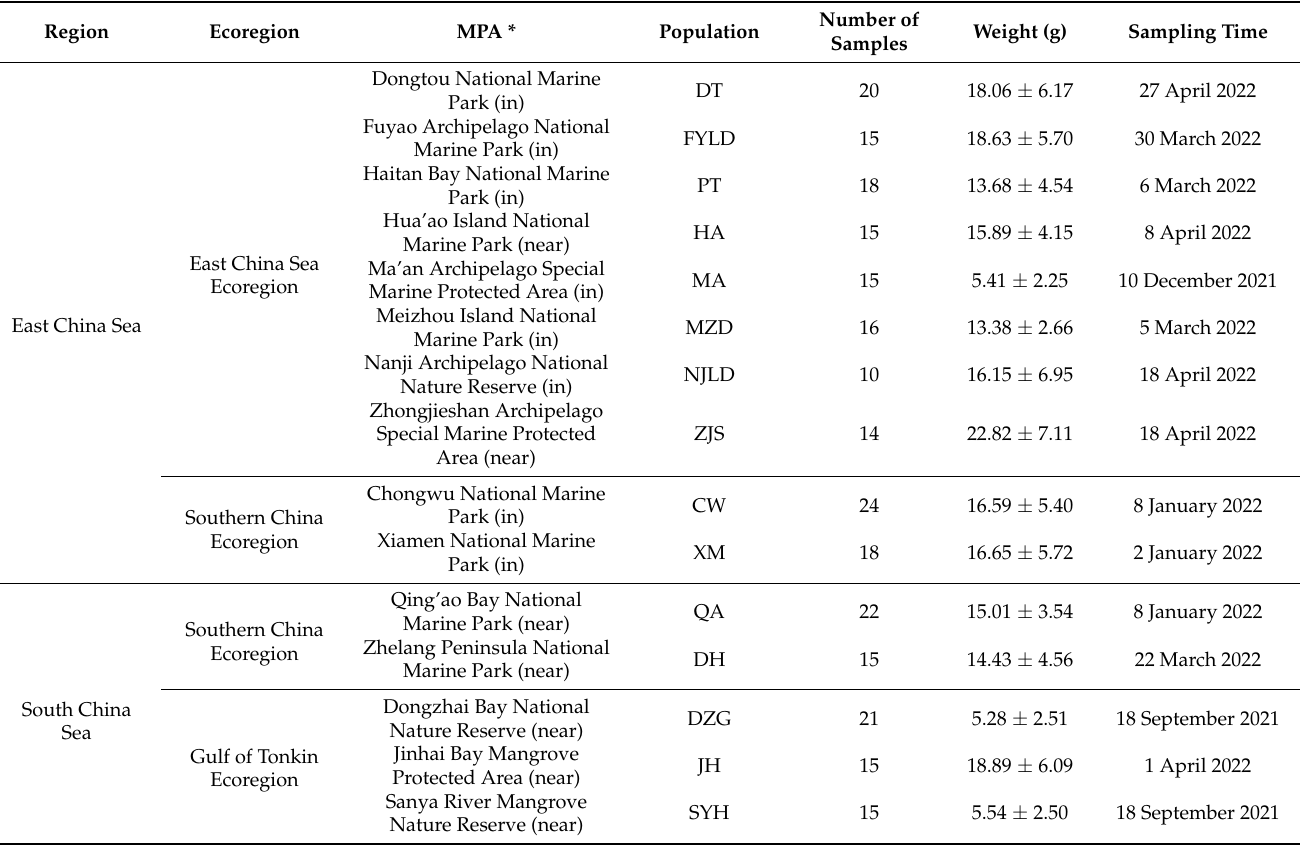
Table 1. Location and sampling details for each